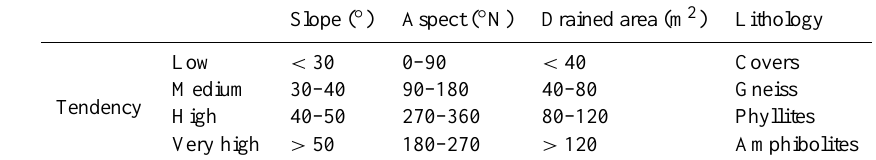
Table 3. Reclassified values used for the data integration resulting in the map of the landslide prone areas.